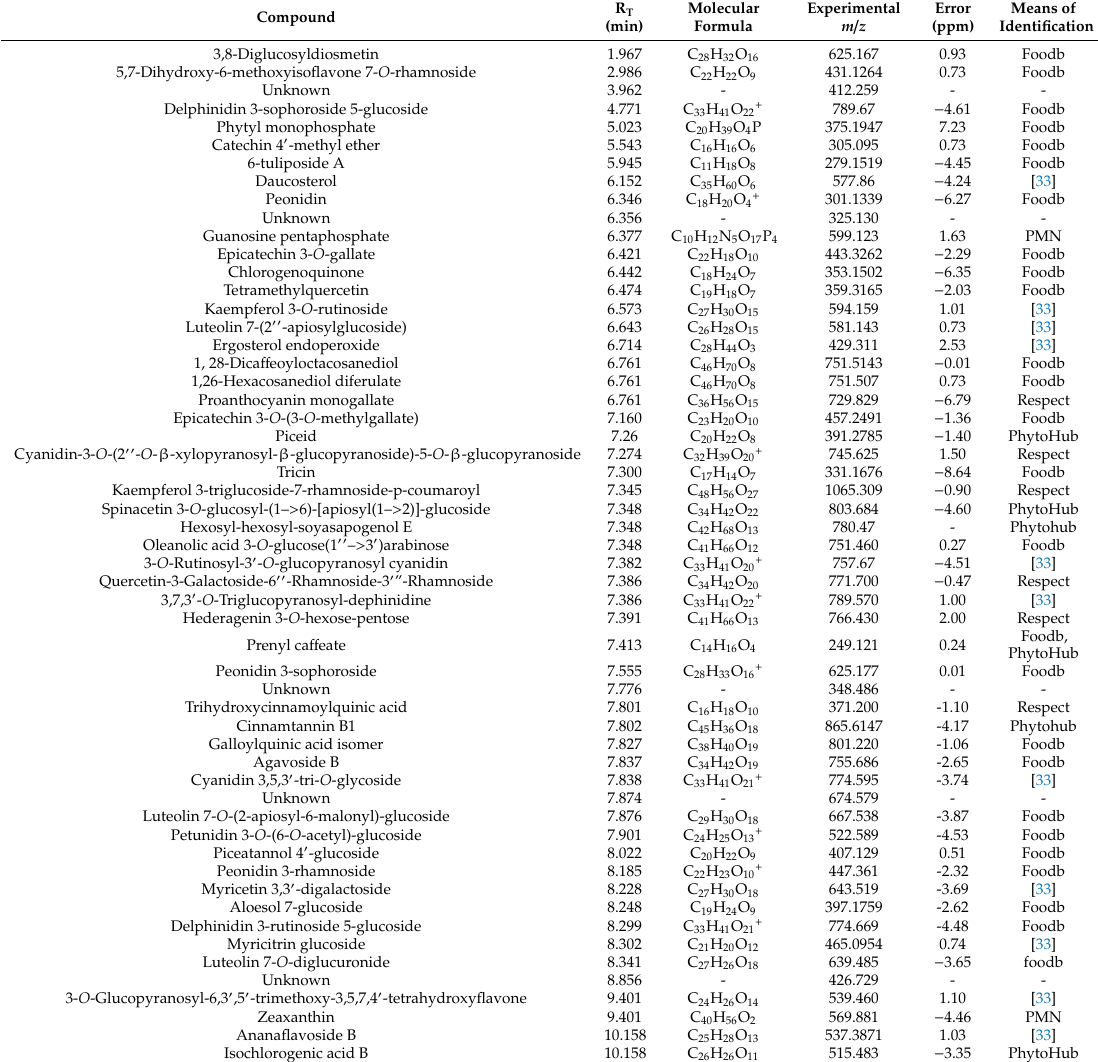
Table 2. Components identified from the aqueous extract of H. glomerata by